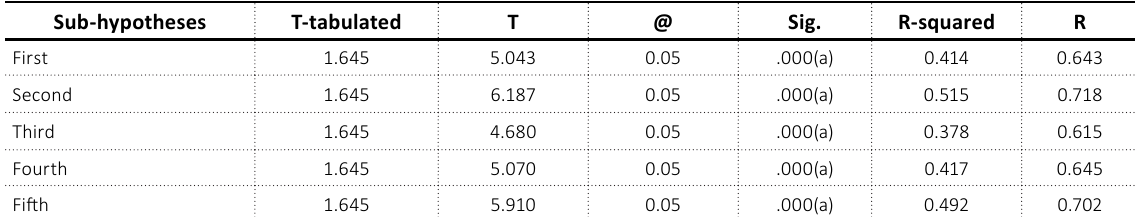
Table 7. The relationship between administration, Zakat funds, other handouts, creditors and suppliers and addressing financial bankruptcy from an Islamic perspective Sub-hypotheses